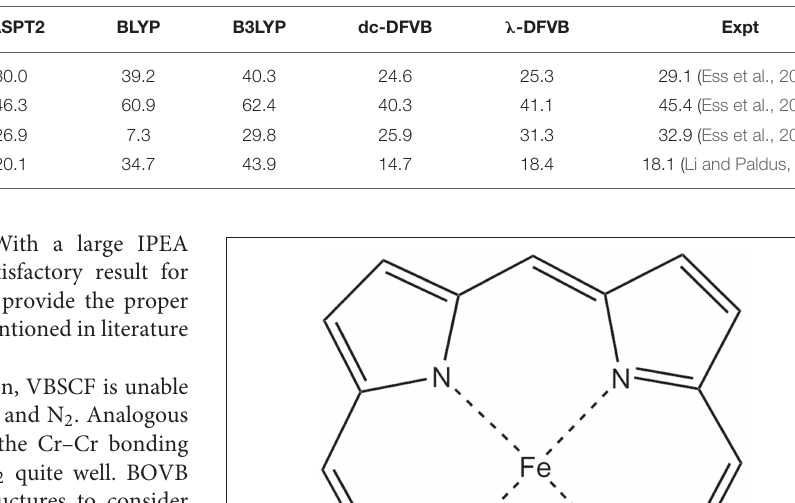
TABLE 4 | The singlet–triplet energy gaps of C, O, carbene (CH 2 ), and trimethylenemethane (TMM) (in kcal/mol).